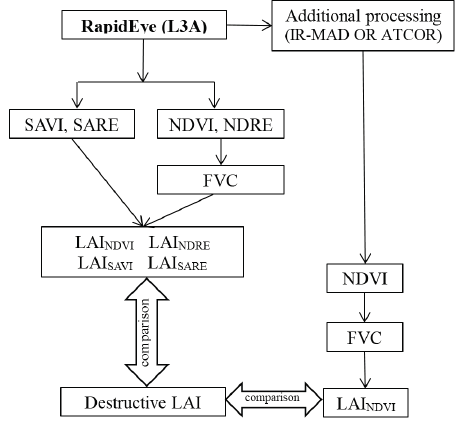
Figure 3. Flowchart description of the